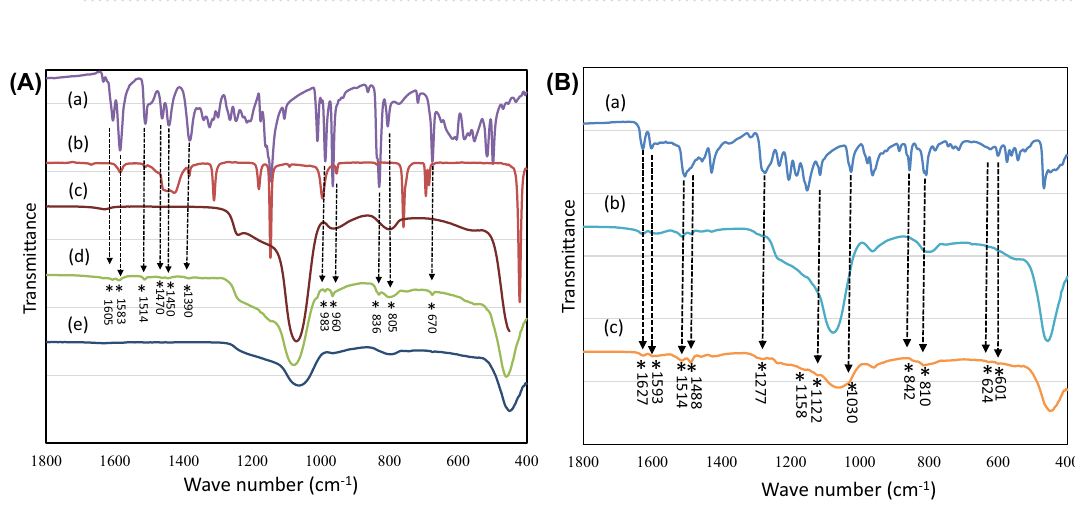
Figure 3. ( A ) FTIR spectra of (a) Resveratrol, (b) ZIF-8, (c) MCM-41, (d) MCM-41/ZIF-8/Resveratrol and (e) KIT-6/ZIF-8/Resveratrol nanocomposites. ( B ) FTIR spectra of (a) Curcumin, (b) MCM-41/ZIF-8/Curcumin and (c) KIT-6/ZIF-8/Curcumin